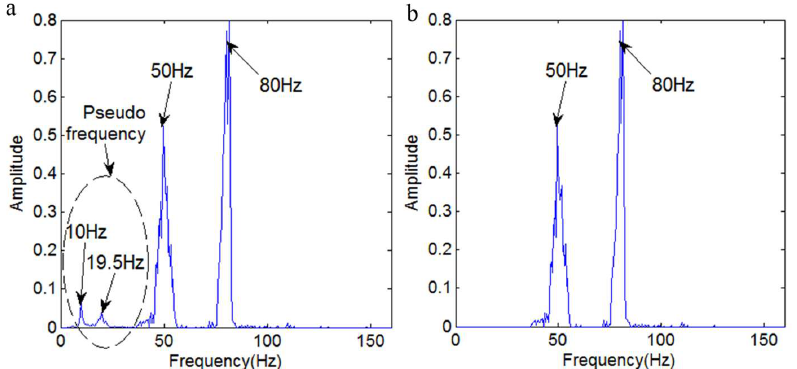
Figure 21. The marginal spectrum. ( a ) The marginal spectrum obtained without eliminating the pseudo frequency; ( b ) The marginal spectrum obtained by eliminating the pseudo frequency.